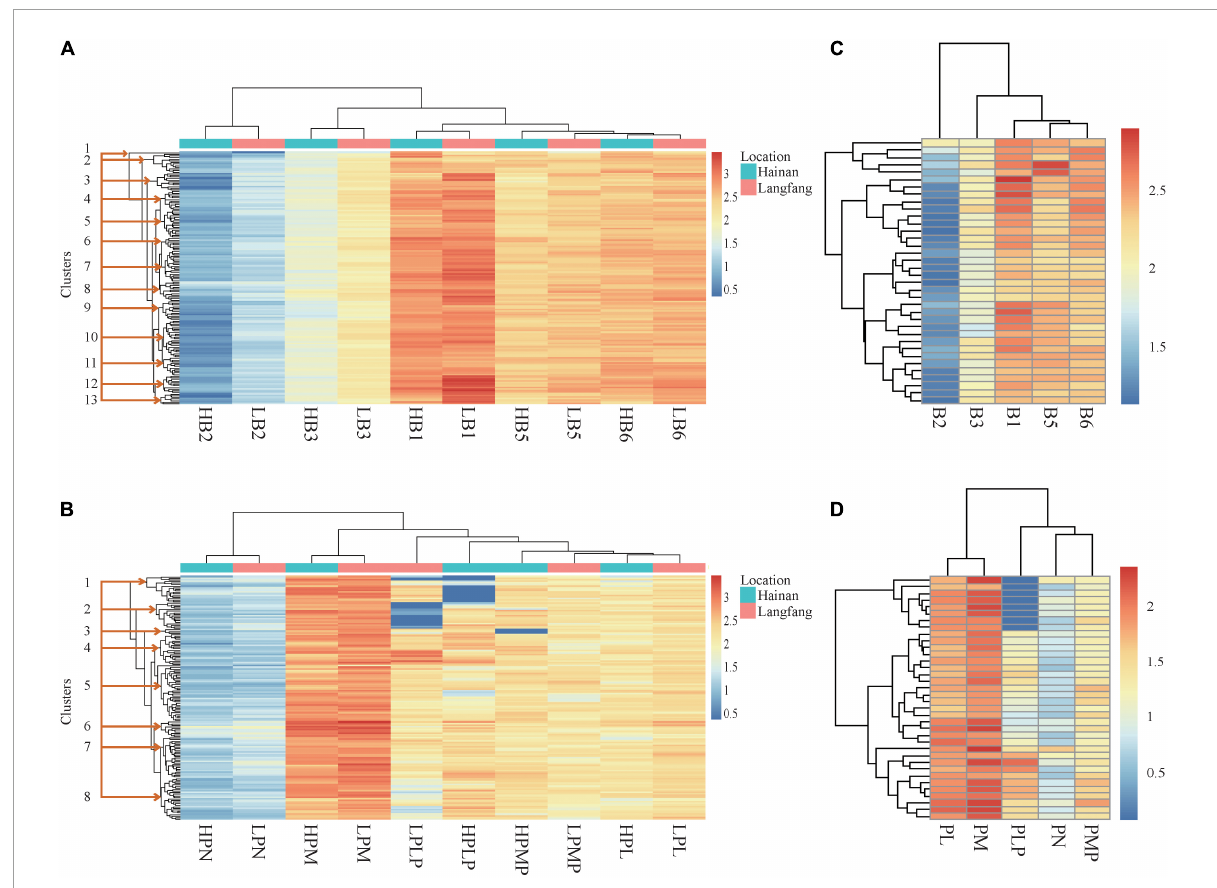
FIGURE1 Heatmaps. (A) Vitamin B1, B2, B3, B5, and total B6 in Hainan and Hebei grain. (B) Derivatives of vitamin B6 in Hainan and Hebei grain. (C) Vitamins B1, B2, B3, B5, and total B6 contents of Hebei hybrids. (D) Derivatives of vitamin B6 in Hebei hybrids. Axes: (bottom) : variables; (top) : hierarchical clusters for closeness between variables; (left) : hierarchical clustering among lines. H, Hainan; L, Langfang (Hebei); B1, thiamine; B2, riboflavin; B3, niacinamide; B5, pantothenic acid; and B6, total of pyridoxine and derivatives; PL, pyridoxal; PLP, pyridoxal 5’-phosphate; PM, pyridoxamine; PMP, pyridoxamine-5’-phosphate; PN,